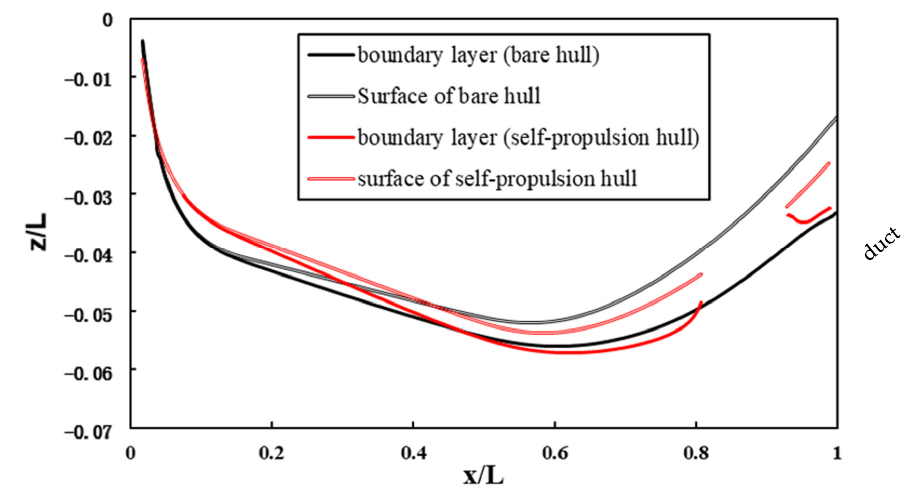
Figure 19. The position of the hull surface and boundary layer.